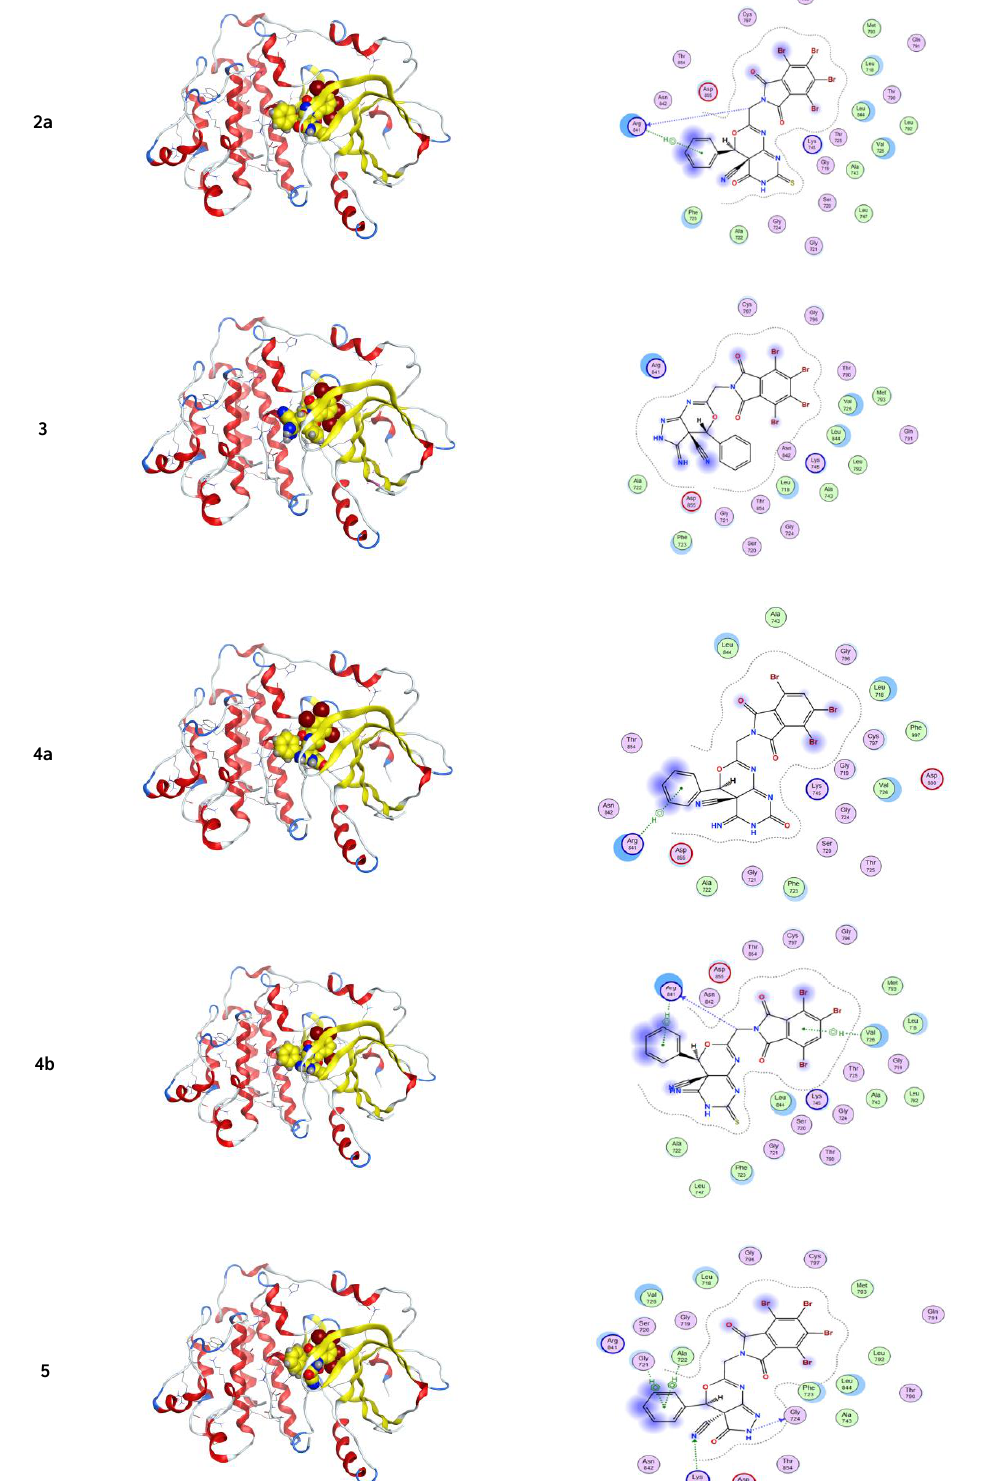
Figure 5. 3D and 2D snapshots showing the hydrophilicity interaction to HeLa caspase3 target receptor “V266”.